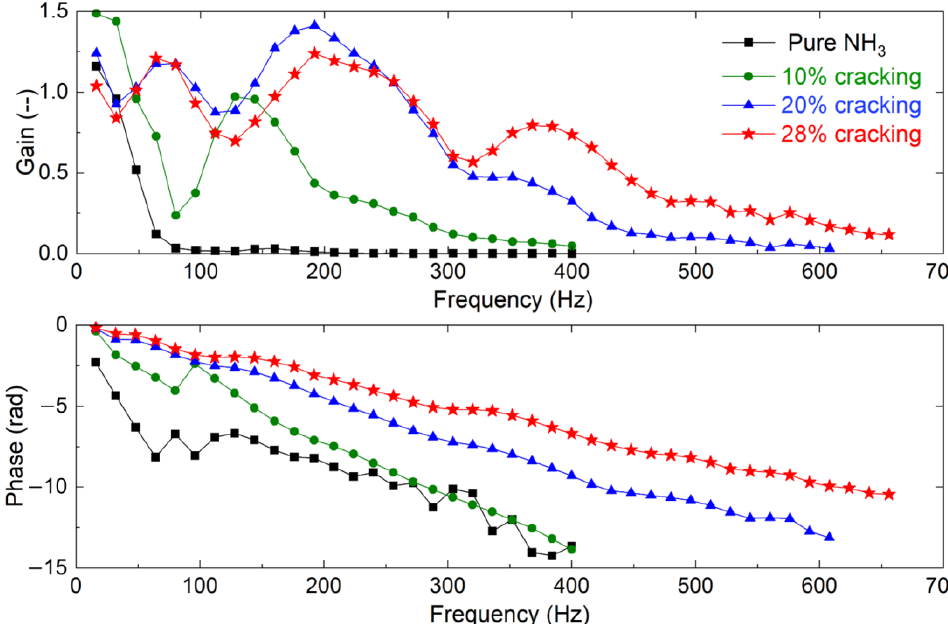
Figure 8. Transfer functions of a pure ammonia flame (black squares) and flames of ammonia at 10% cracking (green circles), 20% cracking (blue triangles), and 28% cracking (red stars). For all flames, the equivalence ratio was 0.95, and the bulk flow velocity was 7 m/s.